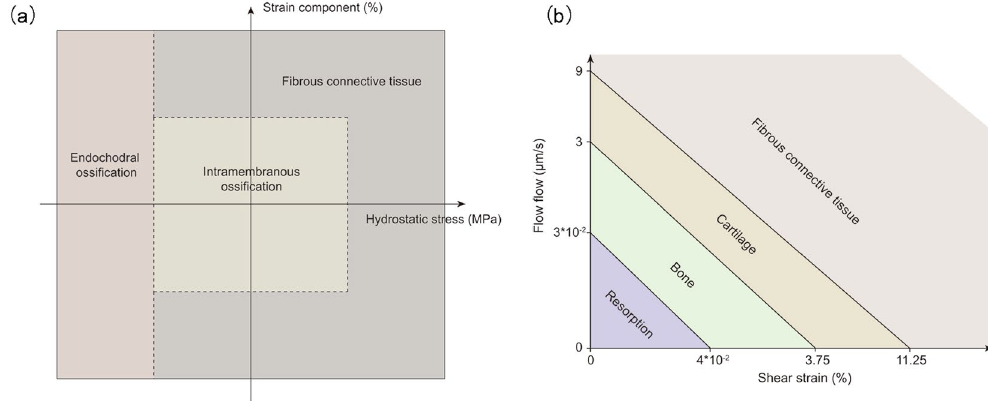
Figure 1. Tissue differentiation pathways regulated by mechanical stimuli. ( a ) Tissue differentiation pathways regulated by hydrostatic stress and strain in single finite element analysis 10 . ( b ) Tissue differentiation pathways regulated by shear strain and fluid flow in biphasic poroelastic finite element analysis 20